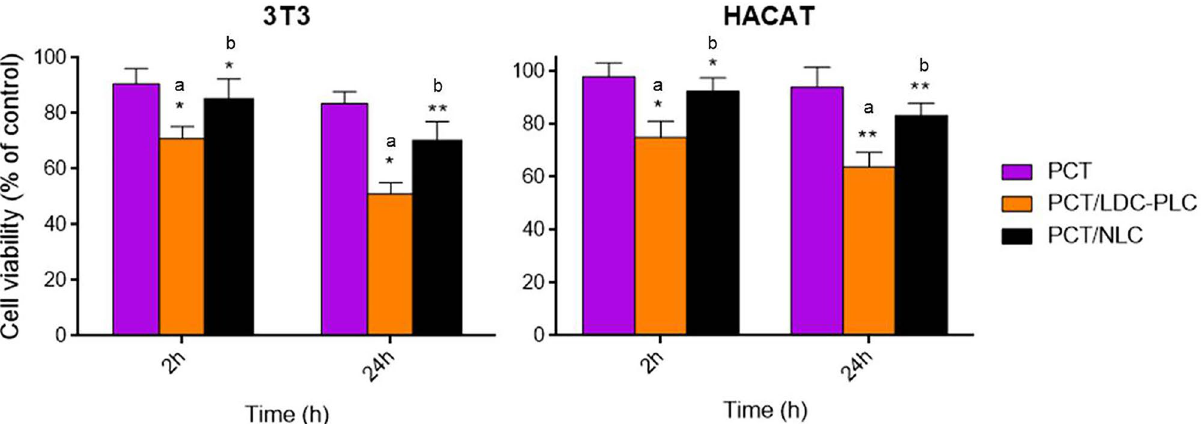
Figure 4. In vitro cell viability (MTT) test in 3T3 (left) and HACAT (right) cells pretreated with pectin (PCT), control (PCT/LDC–PLC) and hybrid (PCT/NLC) films (1 cm 2 ). Data are mean ± S.D. (n = 3). Statistical analyses were carried out by one-way ANOVA/Tukey post hoc tests, *p < 0.05, **p < 0.01. a, PCT/LDC-PLC × PCT; b, PCT/LDC-PLC × PCT/NLC.